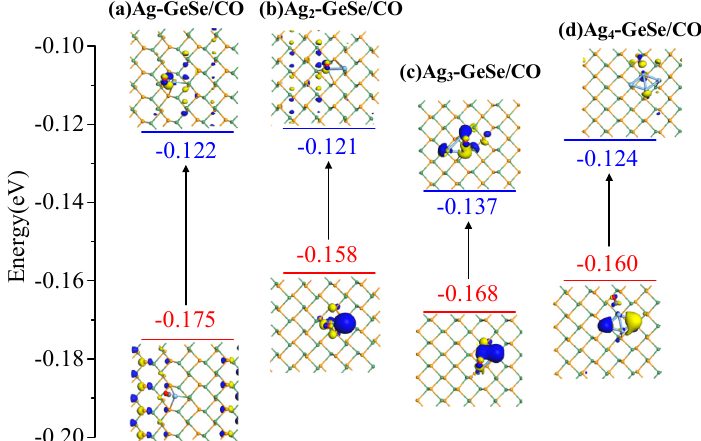
Figure 8. HOMO and LUMO distribution after CO adsorption. ( a ) Ag-GeSe/CO system ( b ) Ag 2 - GeSe/CO system ( c ) Ag 3 -GeSe/CO system ( d ) Ag 4 -GeSe/CO system.